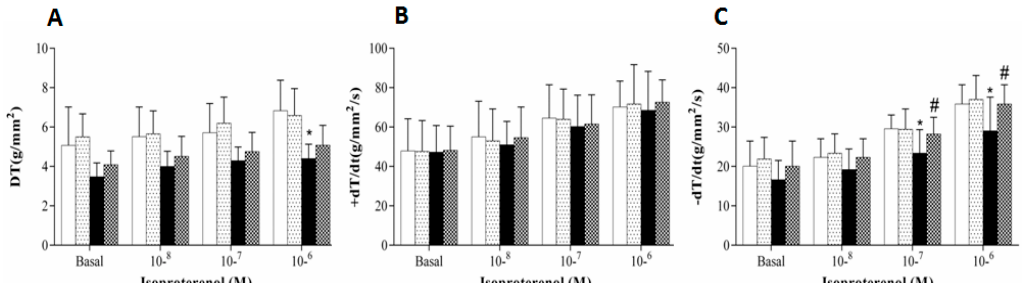
Figure 2. β -adrenergic stimulation in papillary muscles. Data are expressed in mean ± standard deviation ( n = 6 animals / group). Baseline calcium concentration (1.0 mM) is presented as 100%.